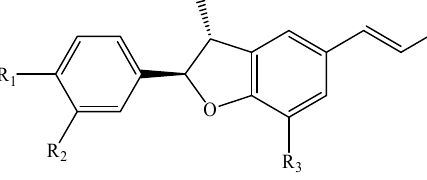
Figure 22. Isolated nor -lignans in the plant kingdom—part 21.